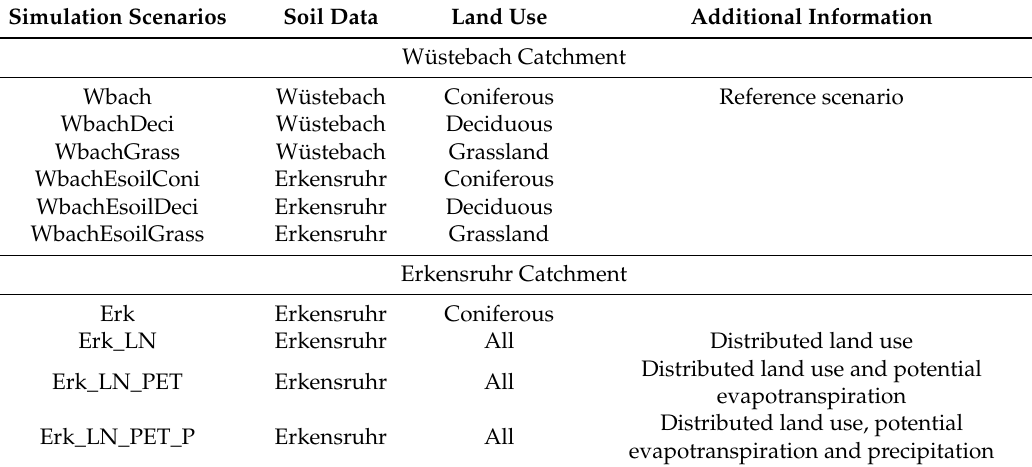
Table 3. Summary of abbreviations of conducted simulations with applied soil and land use